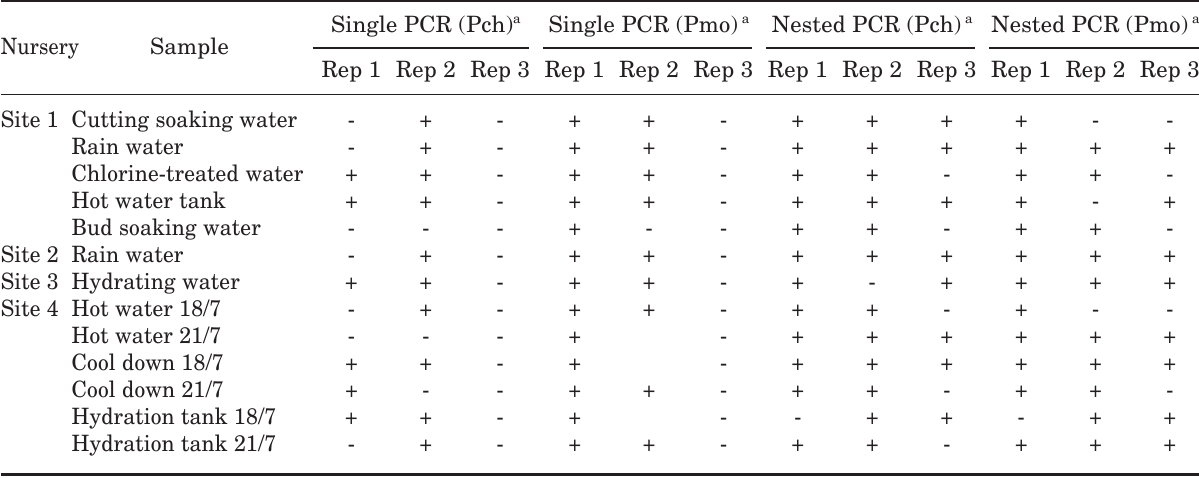
Table 5. Detection of P. chlamydospora in water samples collected from nurseries in July 2005, using non-quantita- tive PCR tests with the two primer sets, Pch (Tegli et al., 2000) and Pmo (Overton et al., 2004).